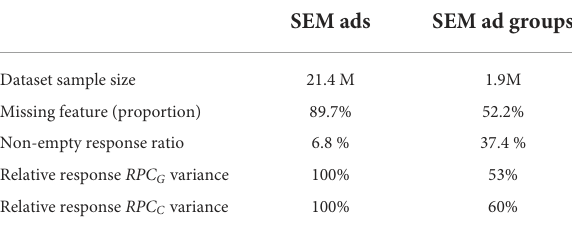
TABLE 4 Search engine marketing ads vs. ad groups: Data-set overview.